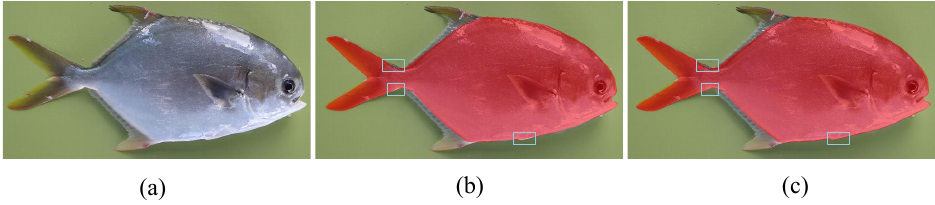
Fig. 9 Comparison of segmentation effects of two algorithms when the fish body is not tilted. Figure 1. Comparison of segmentation results using U-net and improved U-net, respectively. ( a ) Original image; ( b ) The segmentation effect on the edge of the fish using U-net; ( c ) The seg- mentation effect using the improved U-net. Obviously, the latter has a better